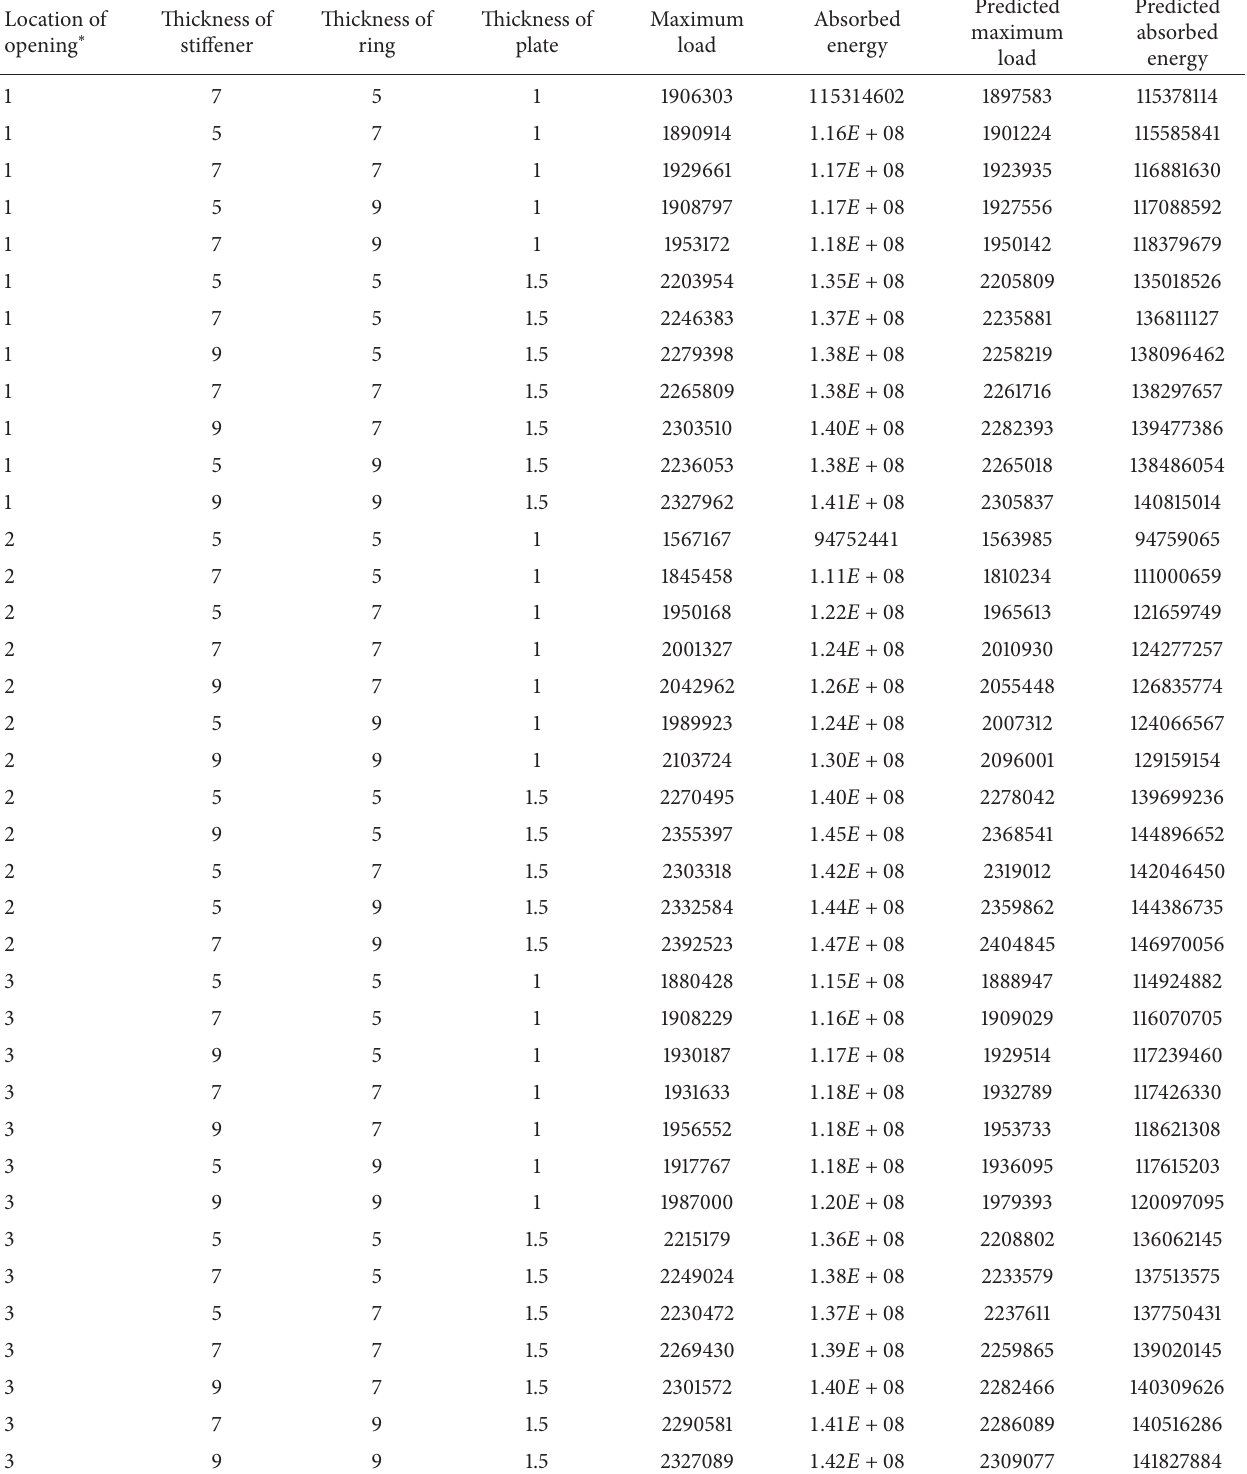
Table 3: The used data in order to train the